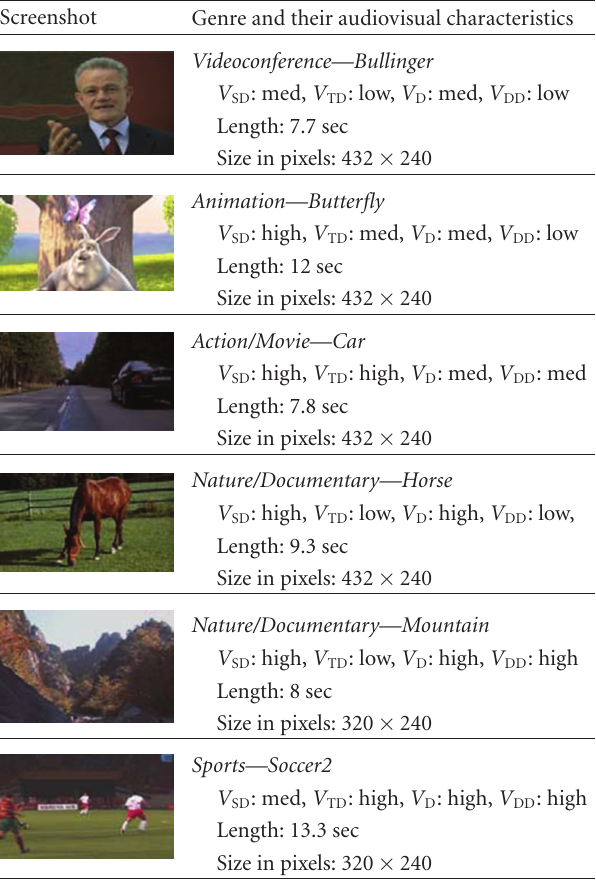
Table 7: Screenshots and characteristics of the test stimuli used in case study